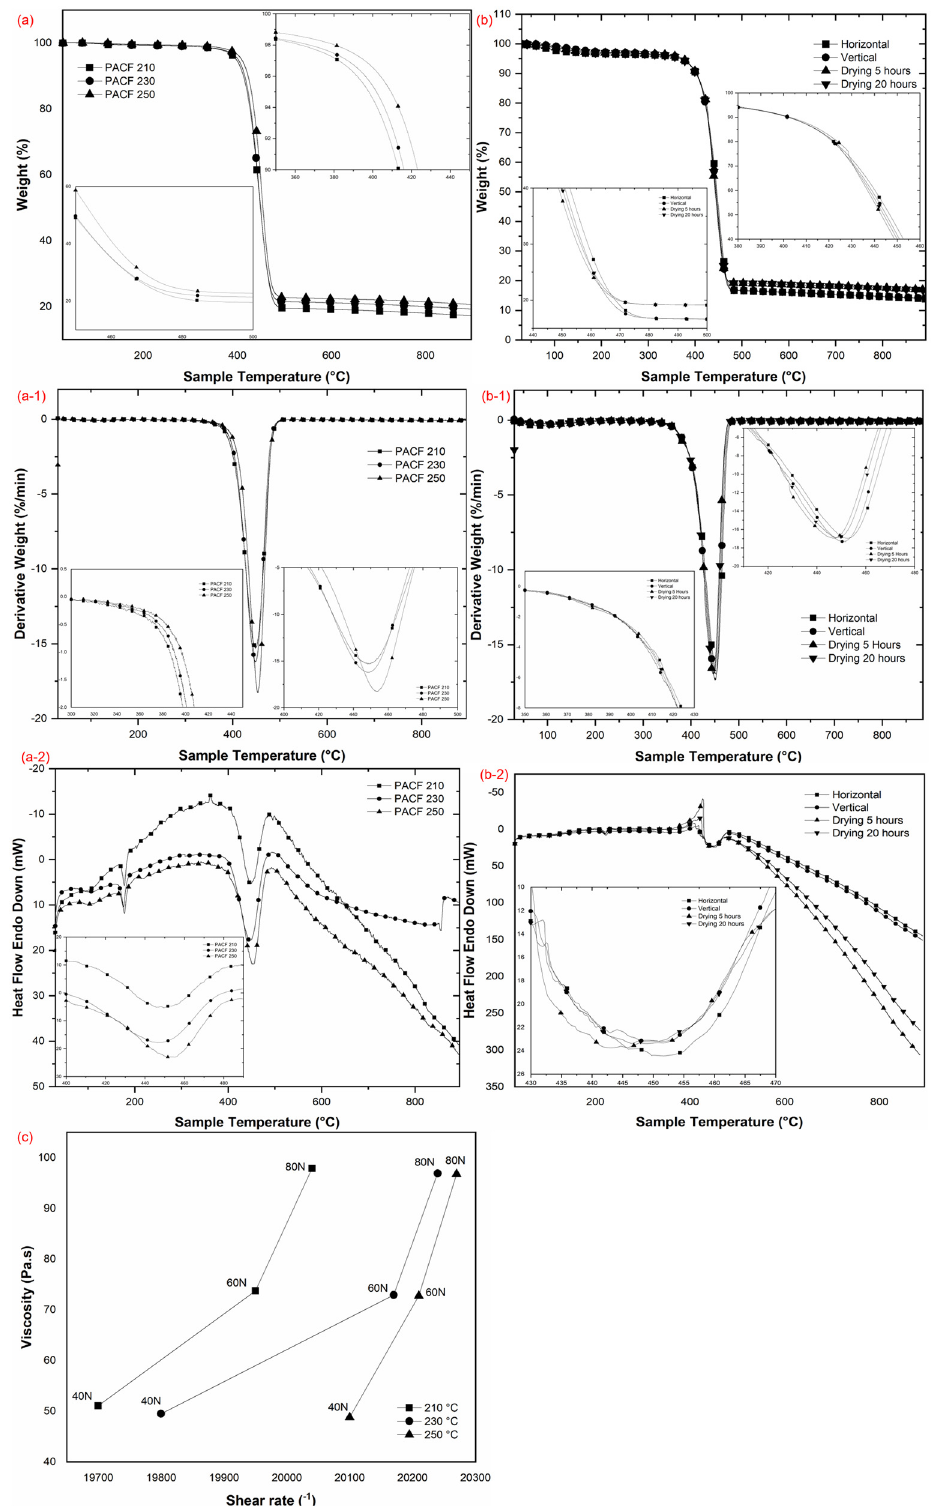
Figure 1: Thermal behaviour of PACF composites as recorded in ( a ) varying printing temperatures, ( b ) di ff erent printing directions and drying times. The derivative weight loss pro fi le of PACF at ( a - 1 ) varying printing temperature and ( b - 1 ) vary printing directions and drying times. The DSC thermograph at ( a - 2 ) varying printing temperature and ( b - 2 ) vary printing directions and drying. The ( c ) rheological properties at temperature of 210°C, 230°C, and